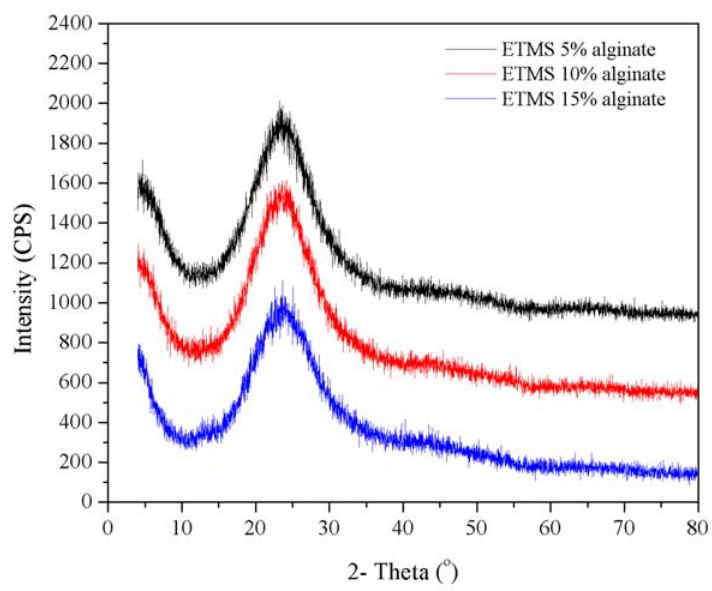
Fig. 3 XRD patterns of silica nanocomposite hybrids (ETMS) containing different quan- tities Calcium alginate.